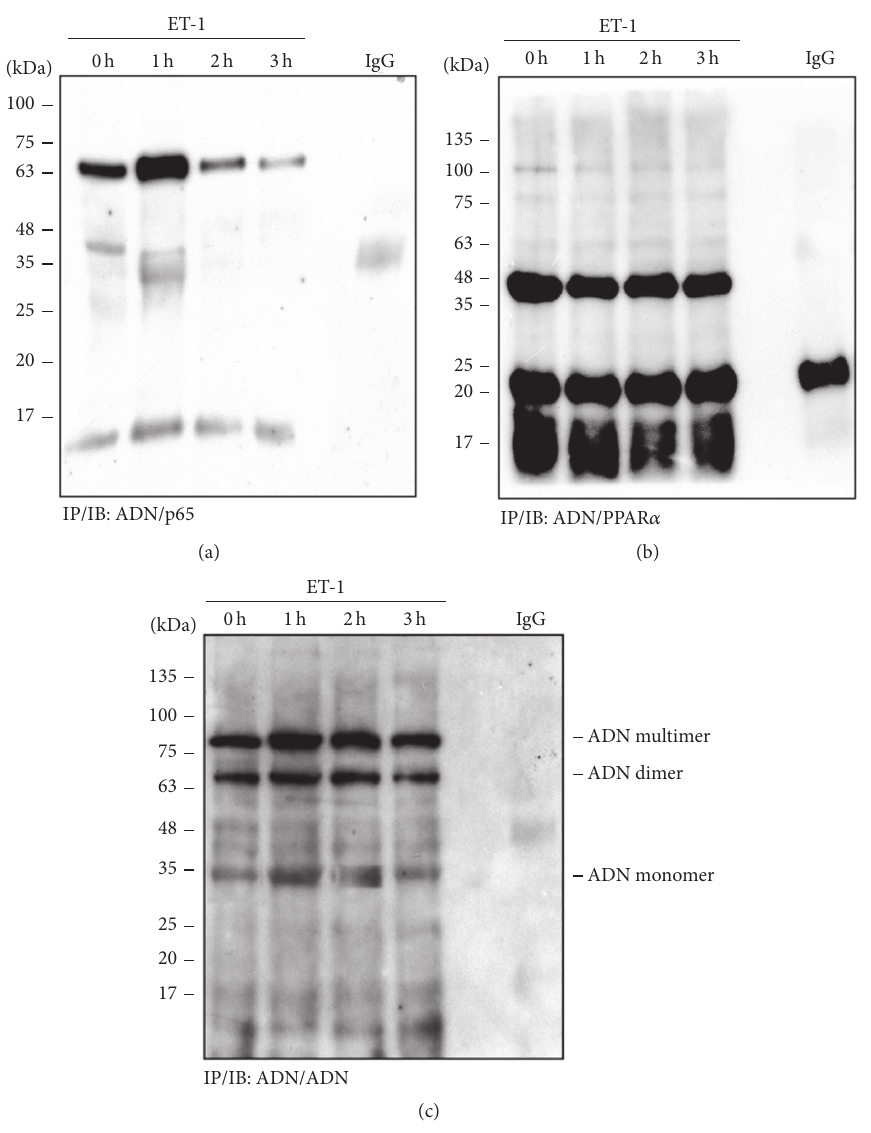
Figure 5: Effects of ET-1 on the association of adiponectin, NF- 𝜅 B, and PPAR 𝛼 in nuclei of cultured human cardiomyocytes. Nuclear proteins extracted from cells were immunoprecipitated with antibodies against adiponectin (ADN) or control mouse IgG and then separated by 12% SDS-PAGE gels before immunoblotting with antibodies against p65 (a), PPAR 𝛼 (b), and adiponectin (ADN) (c). The results were obtained from three independent